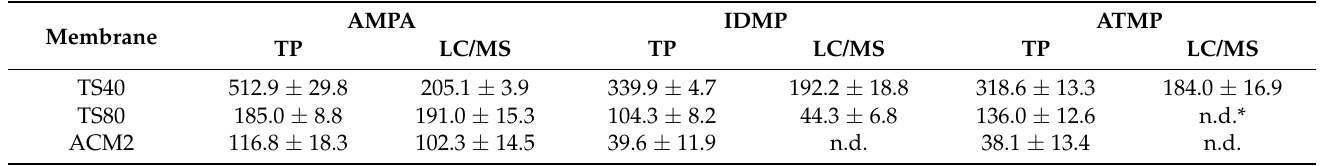
Table 2. Determined phosphonates in permeates with ultra-pure water based on TP and LC/MS analyses ( µ g L − 1 ). Membrane